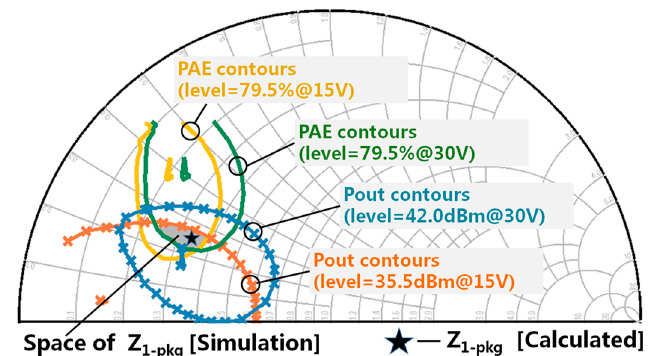
Figure 5. Simulated fundamental load–pull contours of the output power and power added efficiency (PAE) under different drain biases.